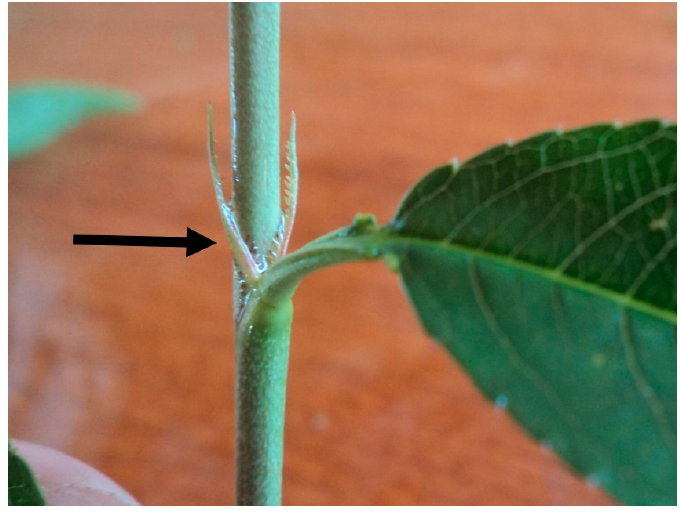
Figure 3. Presence of stipules (indicated by arrow) in peach which are modified leaves with a protecting function.